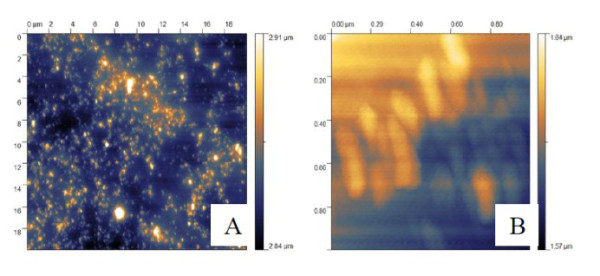
AFM topographic images of physically dispersed Fe3O4 nanoparticles on chitosan gel (A), and immobilization of Fe3O4 nanoparticles in chitosan gel (B).